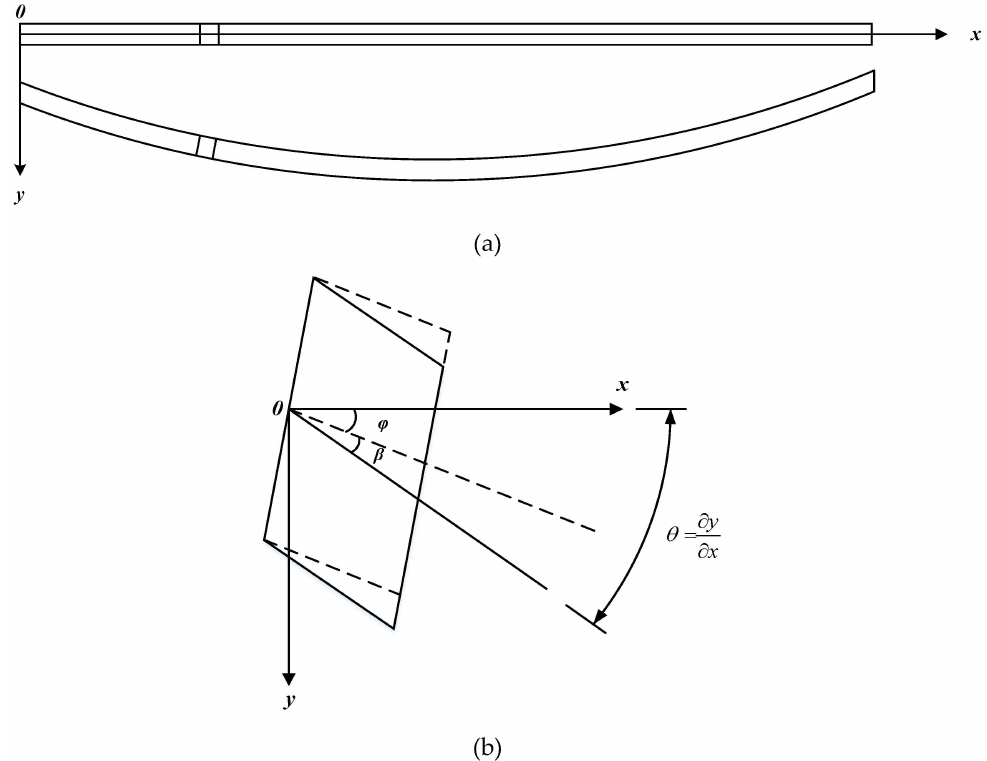
Figure 1. Deformation of the modified Timoshenko beam and a di ff erential element diagram: ( a ) the lateral deformation under lateral load and ( b ) the element